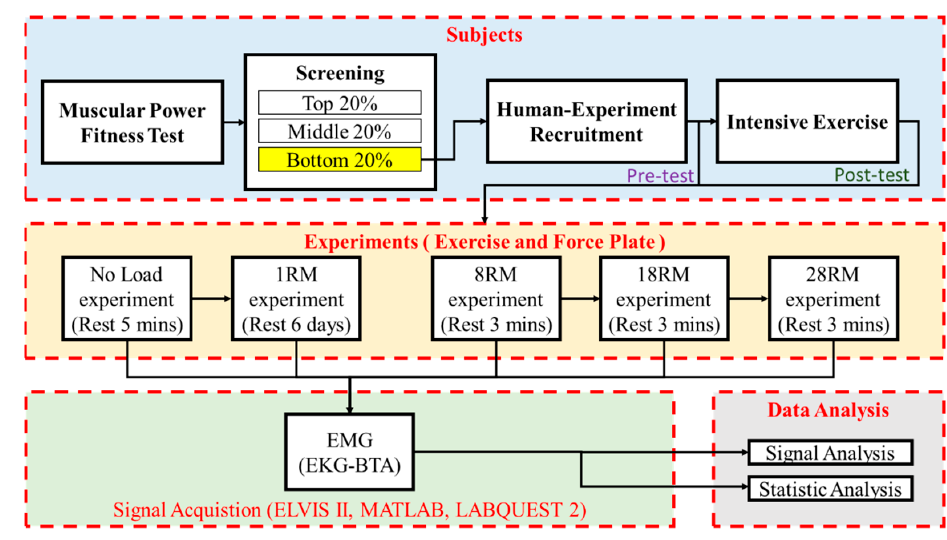
Figure 1. Schematic diagram of experimental procedures.